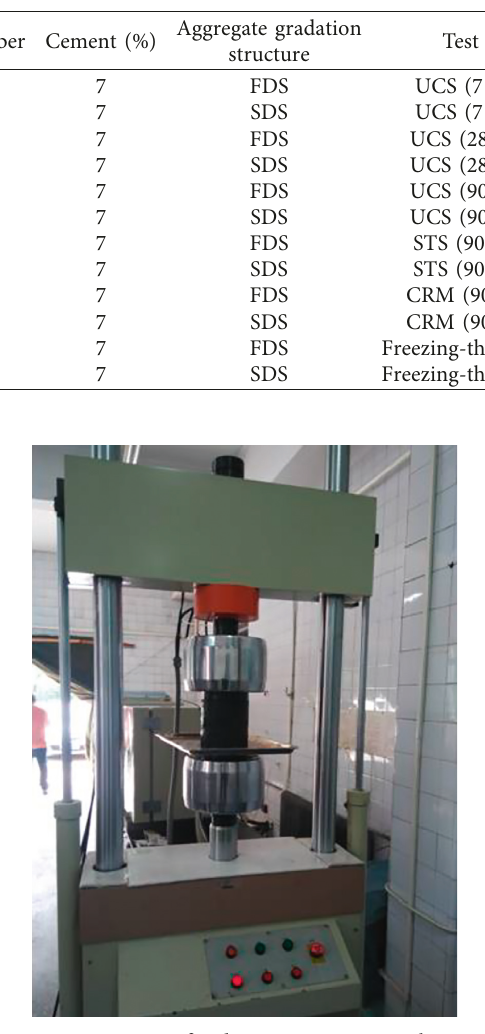
Figure 10: Unconfined compressive strength